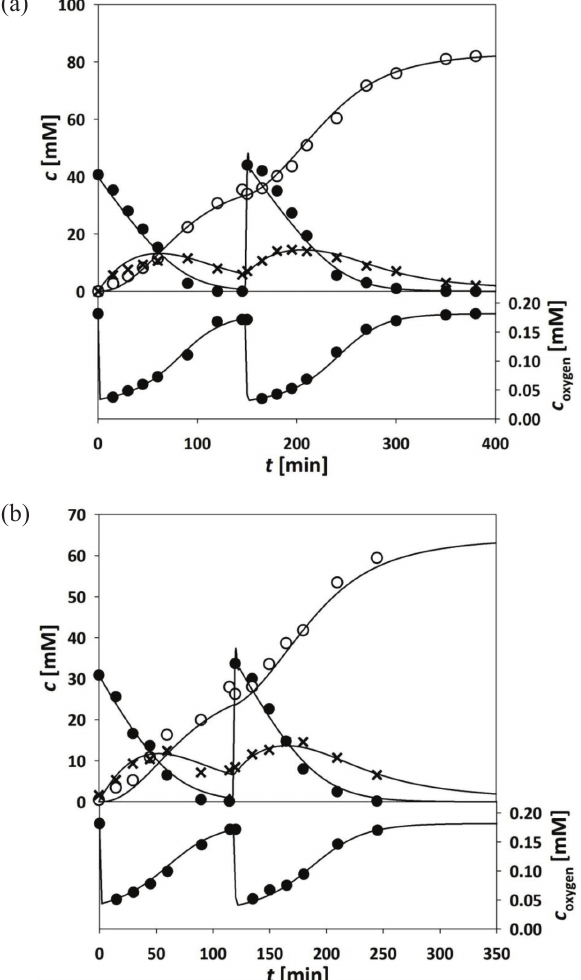
Fig. 8 – Glucose oxidation catalysed by immobilized GOD from Aspergillus niger in the batch reactor (c = 30–40 mM, glucose0 γ = 0.05 mg cm –3 , φ = 0.002, 0.1 M phosphate Eu– GOD Eu–catalase buffer pH = 7; 30 °C; V = 30 cm 3 ) at the aeration level of: reactor a) 15 dm 3 h –1 b) 30 dm 3 h –1 (upper graph: black circle – glucose, white circles –gluconic acid, x – glucono-δ-lactone; bottom graph – oxygen).